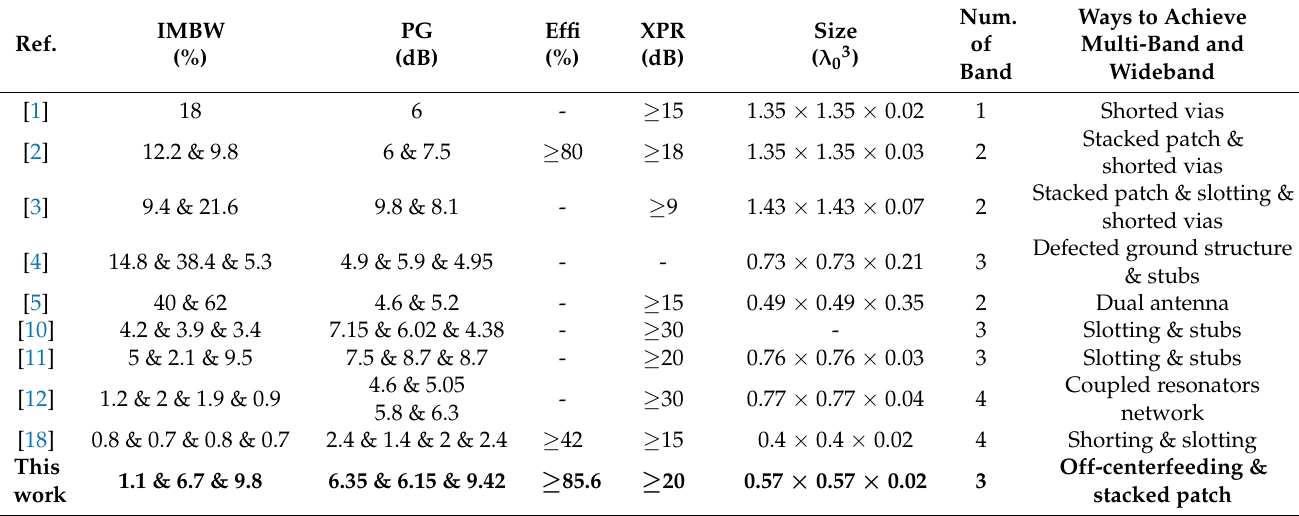
Table 1. Comparison Between Reported and the Proposed